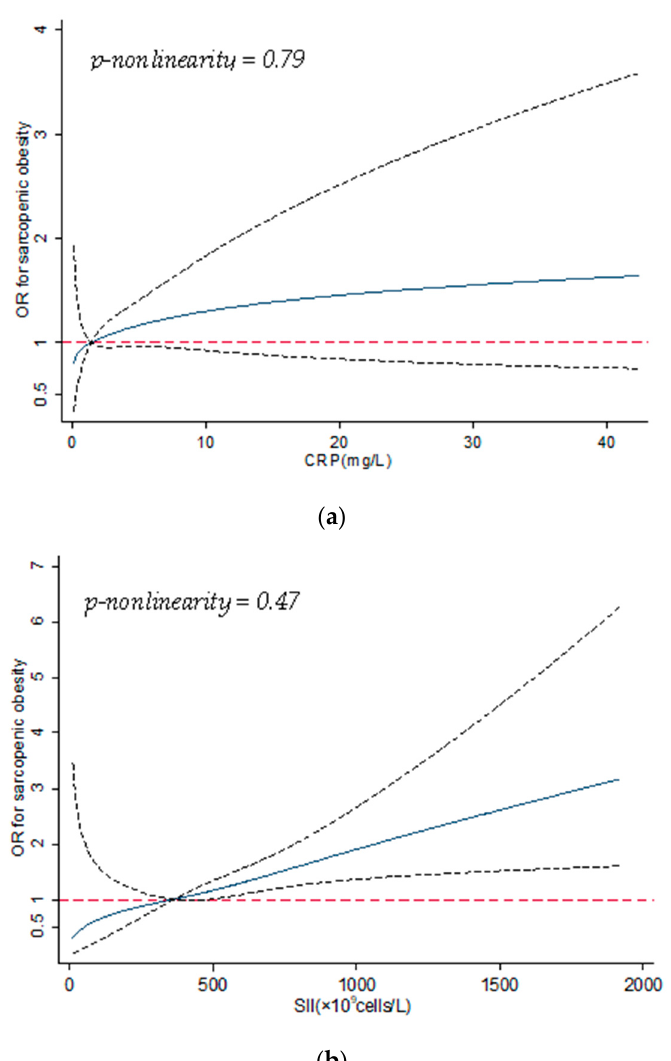
Figure 2. ( a ) Dose–response curve for association between CRP and sarcopenic obesity; the solid line shows the odds ratios (ORs), and the dotted line represents the 95% confidence intervals. CRP = 1.2 mg/L was used as the reference in the curve. Abbreviations—CRP: C-reactive protein. ( b ) Dose–response curve for association between SII and sarcopenic obesity; the solid line shows the odds ratios (ORs), and the dotted line represents the 95% confidence intervals. SII = 365.7 × 10 9 cells/L was used as the reference in the curve. Abbreviations—SII: systemic immune-inflammation index.